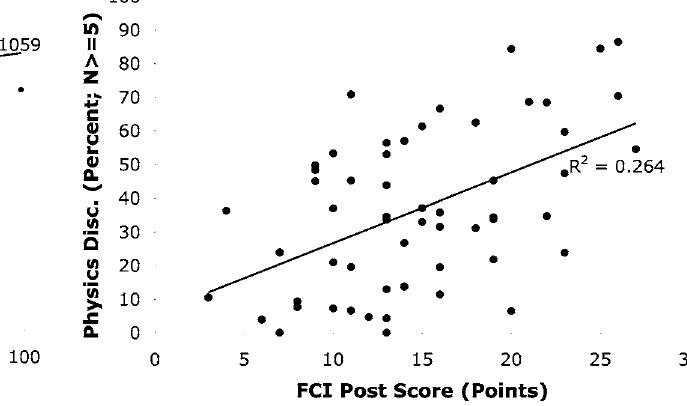
FIG. 3. Correlation of percentage physics-related discussions